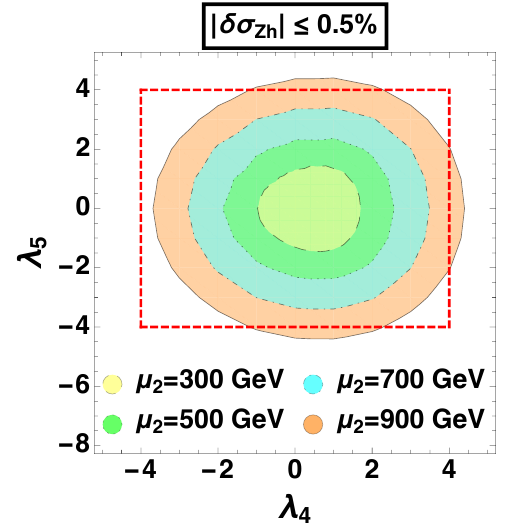
Figure 6. Contours in ( λ 4 , λ 5 ) plane for | δσ Zh | ≤ 0 . 5% in inert double model with µ 2 = 300 , 500 , 700 , 900 GeV , which correspond to concentric areas in yellow, green, cyan and orange, and are respectively outlined with dashed, dotted, dash-dotted and solid lines. With the increase of µ the contour area gets larger and eventually excesses the region of perturbativity of the λ 2 parameters in the scalar potential. The allowed region of perturbativity is dictated within the red dashed box according to (4.7).